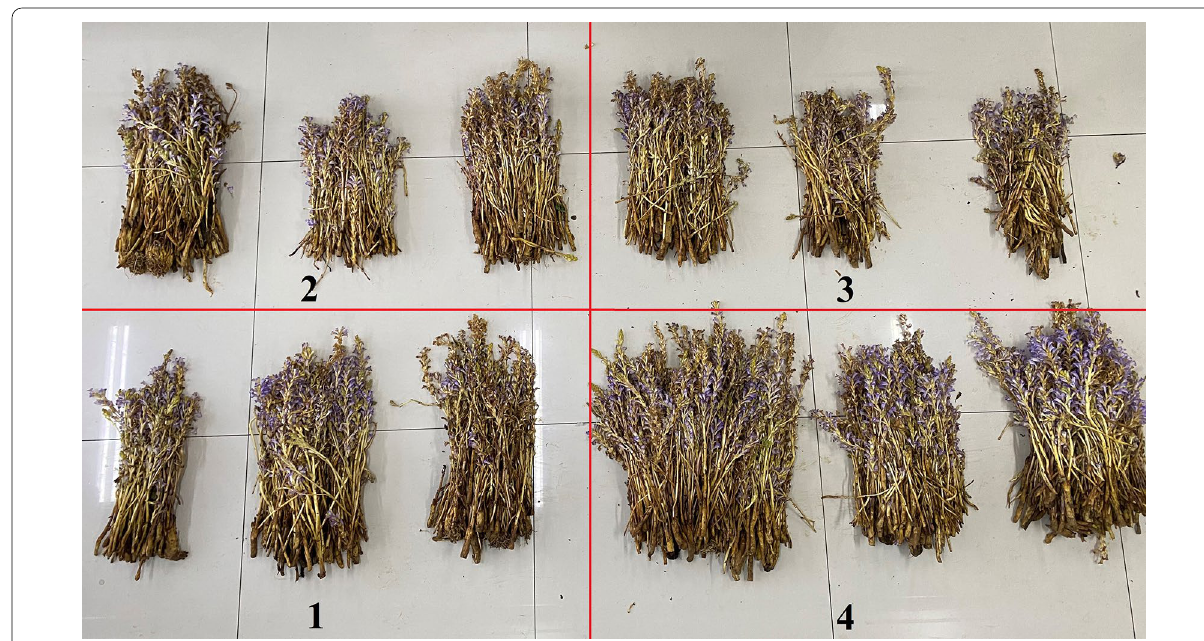
1 was JTB8-2 agent 0.8 L/105m 2 ; 2 was JTB8-2 agent 1.6 L/105m 2 ; 3 was JTB8-2 agent 3.2 L/105m 2 ; CK was water. The different small letters represent significance at 5% level